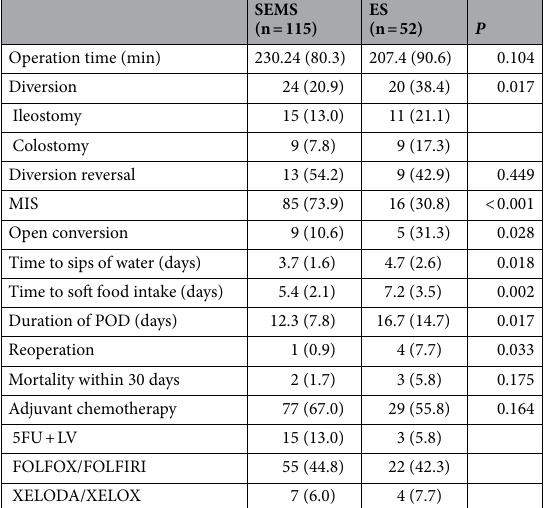
Table 2. Perioperative outcomes in obstructive colorectal cancer. Data are presented as the number of patients (%) or median (standard deviation) unless otherwise stated. SEMS self-expandable metallic stent, ES emergent surgery , n number , MIS minimal invasive surgery , POD postoperative hospital days.